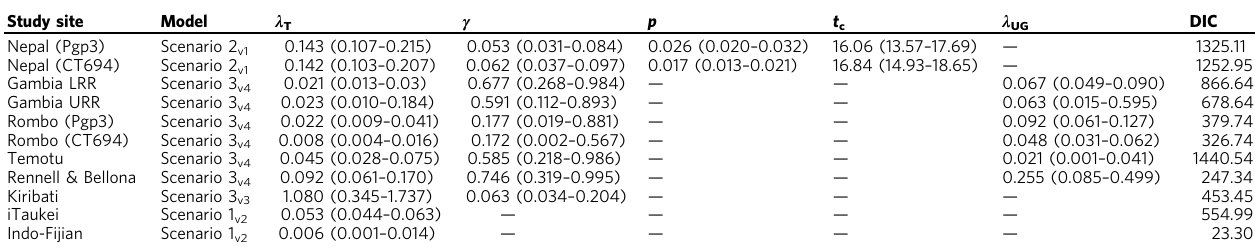
— — — — 23.30 We present the median posterior estimates, the 2.5% and 97.5% credible intervals (CrI) for each parameter for each model and the Deviance information criteria (DIC) for each model (note that DIC values should not be compared between different model fi ts to different data sets). λ T - rate of sero-conversion due to exposure to trachoma, λ UG - rate of sero-conversion due to exposure to urogenital infection, ρ - rate of sero-reversion, t c - fi xed time point at which transmission intensity changed, γ - proportional decline in transmission at t c or over time. Lower River Region (LRR), Upper River Region